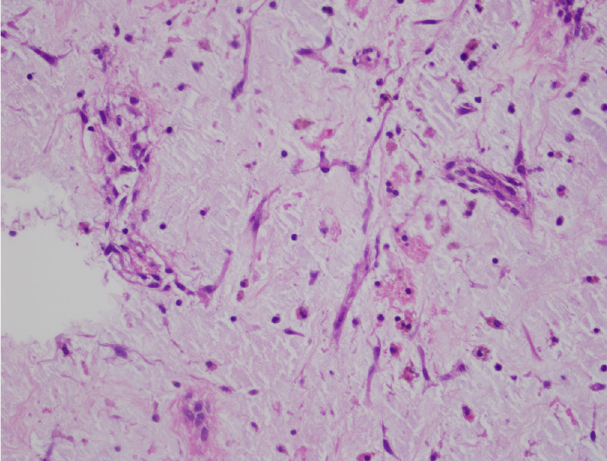
Fig. 2 – Postoperative histological specimen revealed myxoma cells, short strands embedded in the myxoid